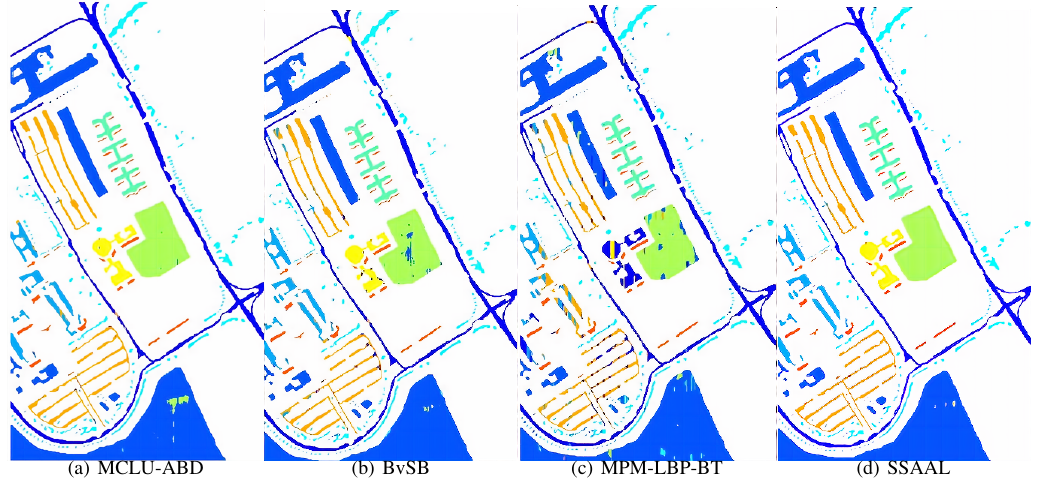
Figure 8. Classification maps obtained by different AL techniques on Pavia University